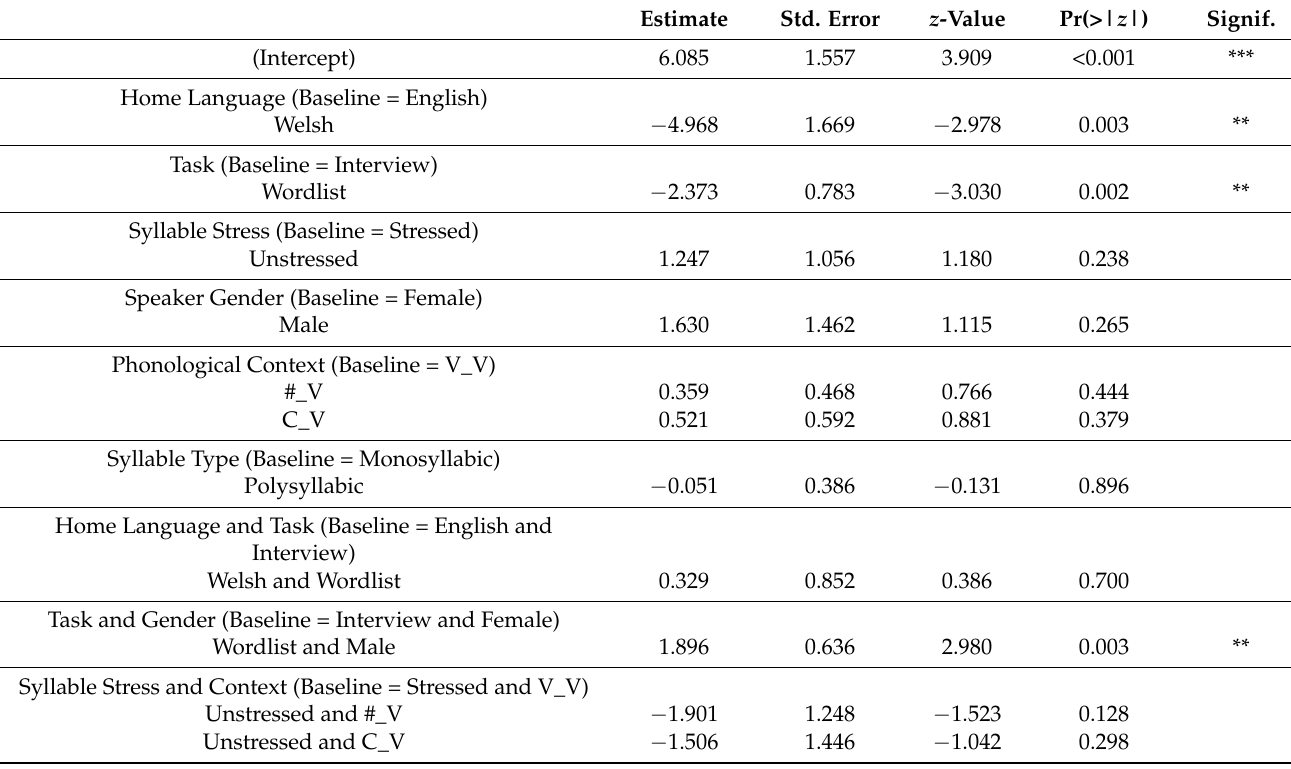
Table 7. Regression coefficients with z - and p -values for the final model predicting the production of the alveolar approximant in the Caernarfon English-language subset ( n = 759). Positive estimates indicate an increased likelihood of the alveolar approximant. AIC =